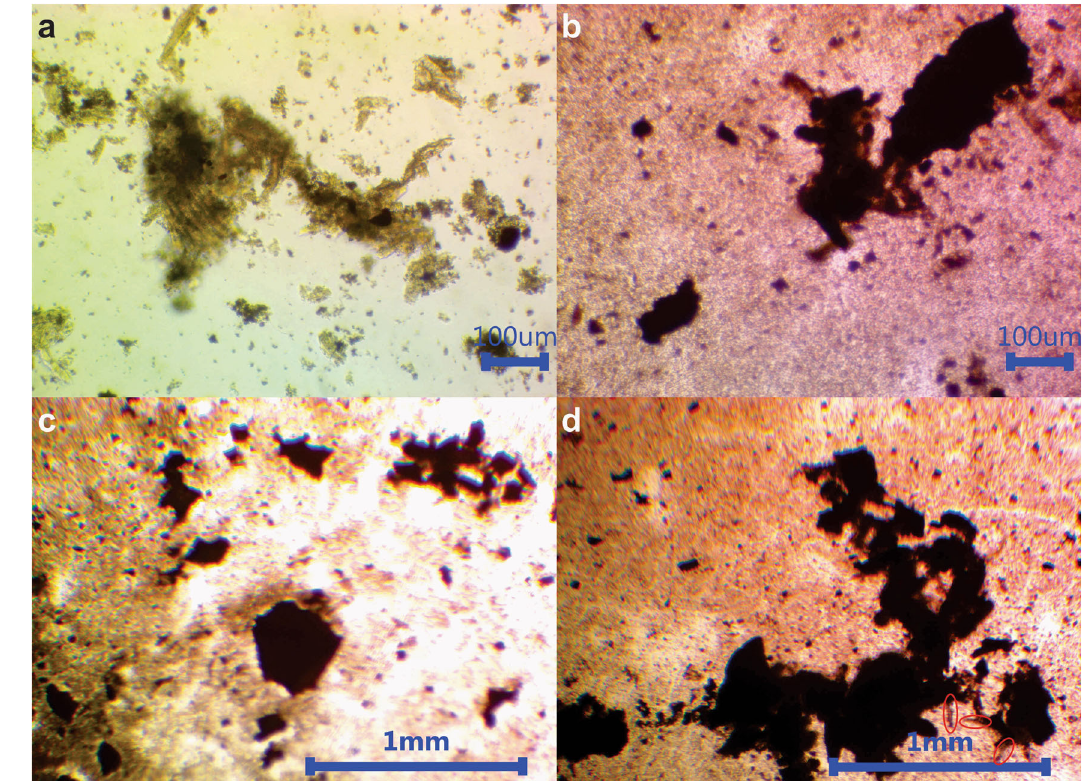
Fig. 4 Cardiomyocytes with PPPyN a 1 day of culture. b 8 days of culture. c 15 days of culture. d 30 days of culture